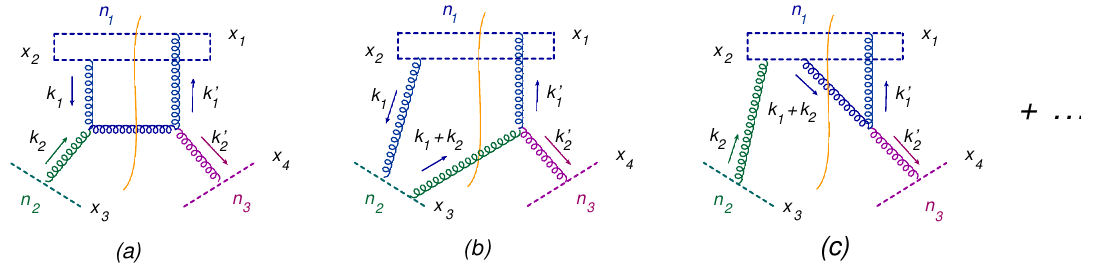
Figure 15 . First rung of the BFKL evolution in the triple Regge